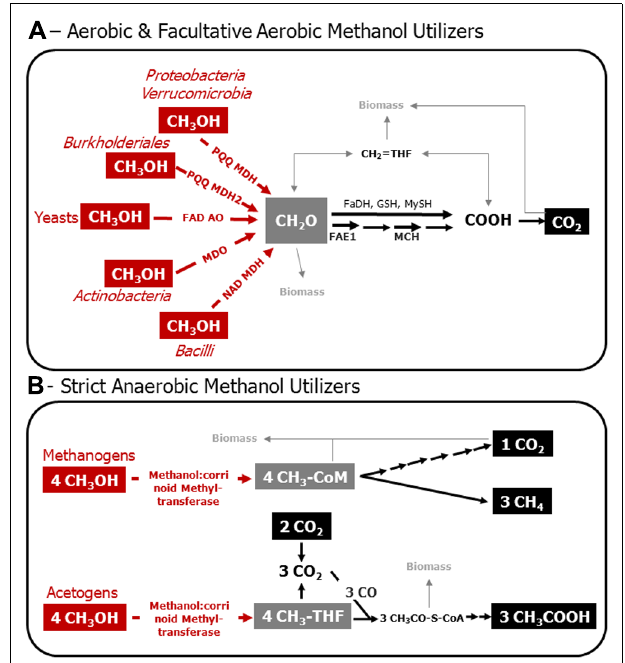
FIGURE 1 | Model of the C1 metabolism of aerobic and facultatively aerobic methanol utilizers (A), and of methanol-utilizing methanogens and acetogens (B) .Various Bacteria that employ PQQ MDH and PQQ MDH2 utilize nitrate besides molecular oxygen, and are, thus, facultative aerobes. Red, enzymatic reactions indicative for methanol utilization. Gray, metabolic crossing points to anabolic pathways. Structural genes are targets for the molecular assessment of methanol-utilizing microorganisms in the environment. PQQ MDH, PQQ-dependent methanol dehydrogenase; PQQ MDH2, alternative PQQ-dependent methanol dehydrogenase in Methylibium and Burkholderia strains; FAD AO, FAD-dependent alcohol oxidoreductase; MDO, methanol oxidoreductase; NAD MDH, NAD-dependent methanol dehydrogenase; FAE1, tetrahydromethanopterin-dependent formaldehyde activating enzyme; MCH, tetrahydromethanopterin-dependent methenyl-methylene cyclohydrolase; FaDH, formaldehyde dehydrogenase; GSH, glutathione-dependent formaldehyde oxidation; MySH, mycothiol-dependent oxidation of formaldehyde in yeast; CH 2 = HF4, methylene tetrahydrofolate; CH 3 -THF, methyl-tetrahydrofolate; CH 3 -CoM, methyl-coenzyme M; CH 3 OH, methanol; CH 2 O, formaldehyde; COOH formate; CO 2 , carbon dioxide; CO, carbon monoxide; CH 3 CO–S–CoA, acetyl coenzyme A; CH 3 COOH, acetic acid. Biomass, assimilation of carbon occurs at the level of formaldehyde and/or on carbon dioxide in aerobic methylotrophs; pathways involved are the Calvin–Benson–Bassham cycle, ribulose-monophosphate pathway, and the serine cycle. Assimilation of carbon in methanogens is mediated by a unique reductive acetyl-CoA-pathway, whereas acetogens form acetyl-CoA as an intermediate that can be used for biosnthesis.This figure is based on previous articles (Thauer, 1998; Ding etal., 2002; Hagemeier etal., 2006; Das etal., 2007; Drake etal., 2008; Chistoserdova etal., 2009; Chistoserdova, 2011; Gvozdev etal.,